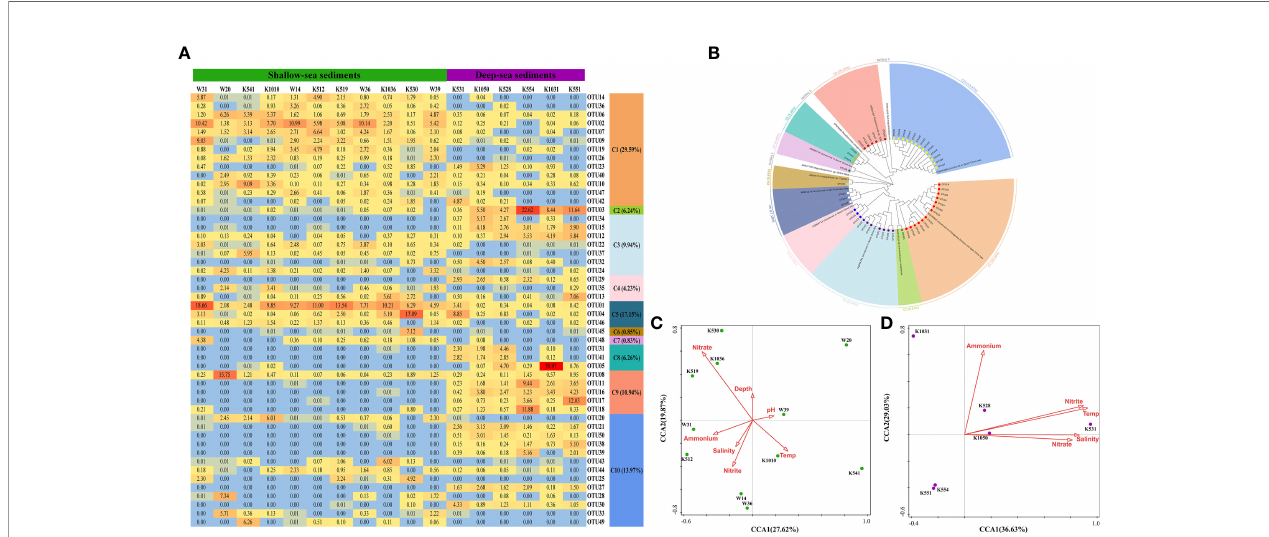
FIGURE 3 | Microbial characteristics of the nir S gene in surface sediments of the northern SCS. (A) The heat map of dominant OTUs for the nir S gene (Top 50 OTUs). (B) Neighbor-joining phylogenetic tree of dominant OTUs for the nir S gene (Top 50 OTUs) and the reference sequences from Genbank (bootstrap 1000). (C) The canonical correspondence analysis (CCA) for the nir S gene derived from shallow-sea surface sediments. (D) The canonical correspondence analysis (CCA) for the nir S gene derived from deep-sea surface